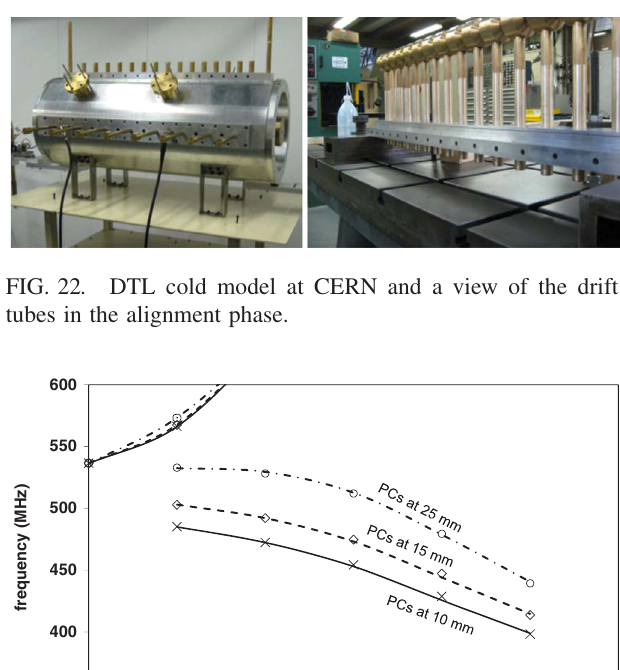
and TM modes. 010 011